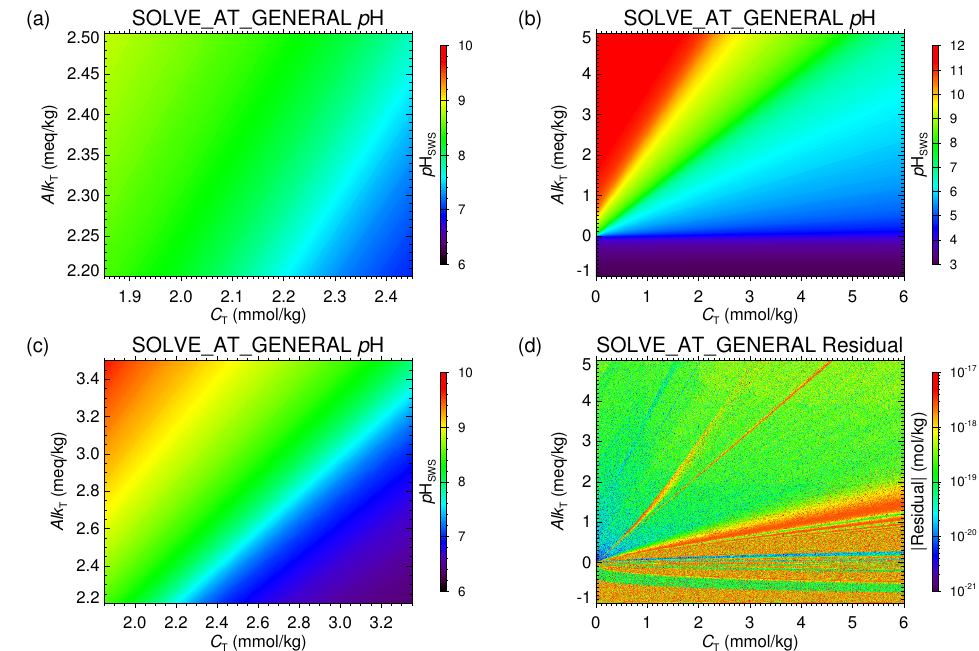
Fig. 1. pH SWS values obtained with the new universal algorithm ( general ) for test cases (a) SW1, (c) SW2 and (b) SW3 – please notice the extended colour scale. (d) Absolute value of the equation residual at the adopted root value, derived with that same algorithm started with the cubic-based initialization to solve test case SW3. Applied convergence criterion: | H n + 1 − H n | /H n < 10 − 8 .